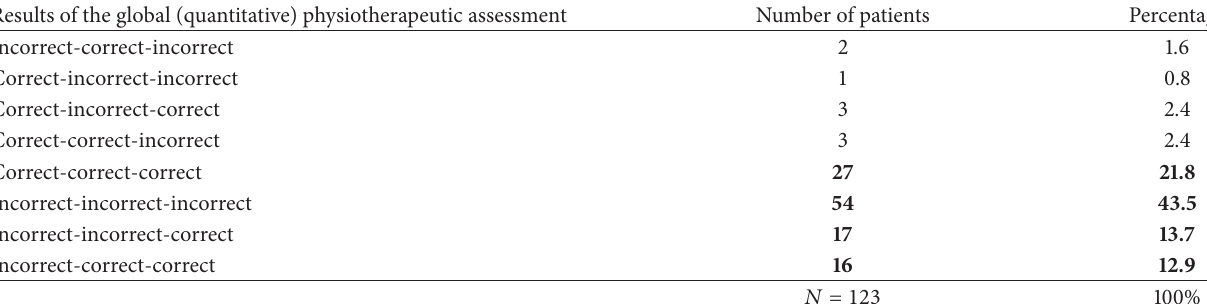
Table 2: Global (quantitative) assessment of development at 3, 6, and 9 months, performed by the physiotherapist. Results of the global (quantitative) physiotherapeutic assessment